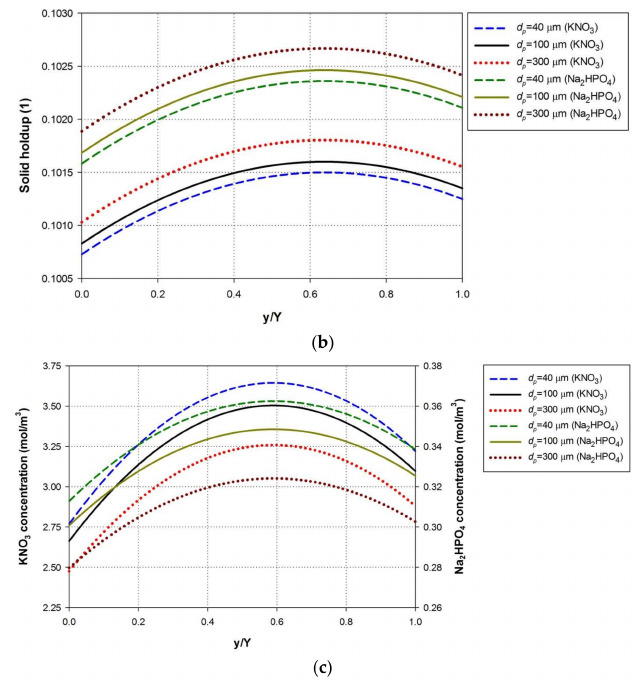
Figure 9. Effects of nutrient diameters (m) on ( a ) mass transfer coefficient; ( b ) solid holdup; and ( c ) nutrient concentrations in a raceway pond with AR = 10, water depth = 0.2 m, and paddle wheel speed =